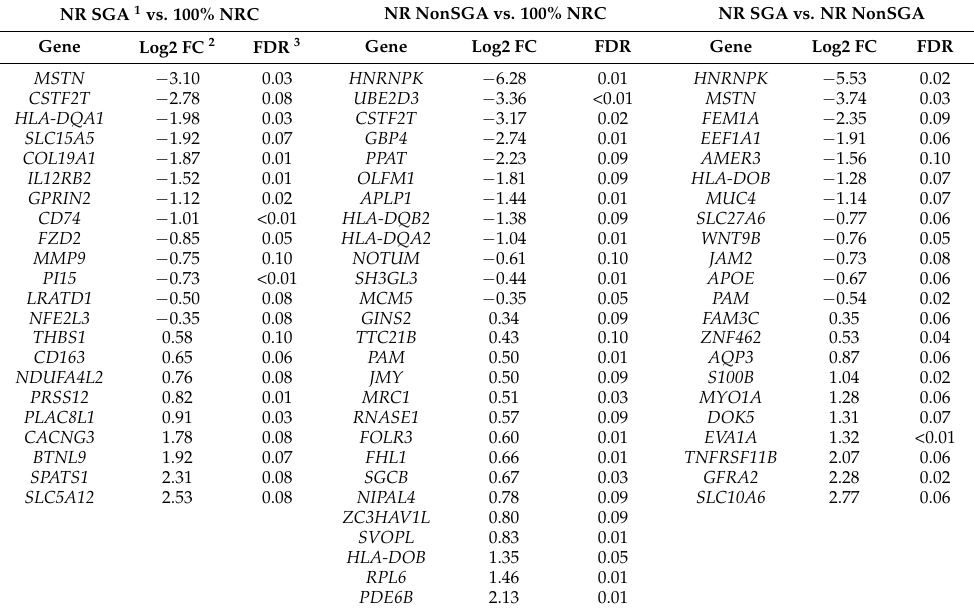
Table 1. Differentially expressed genes in placentomes at day 70 of